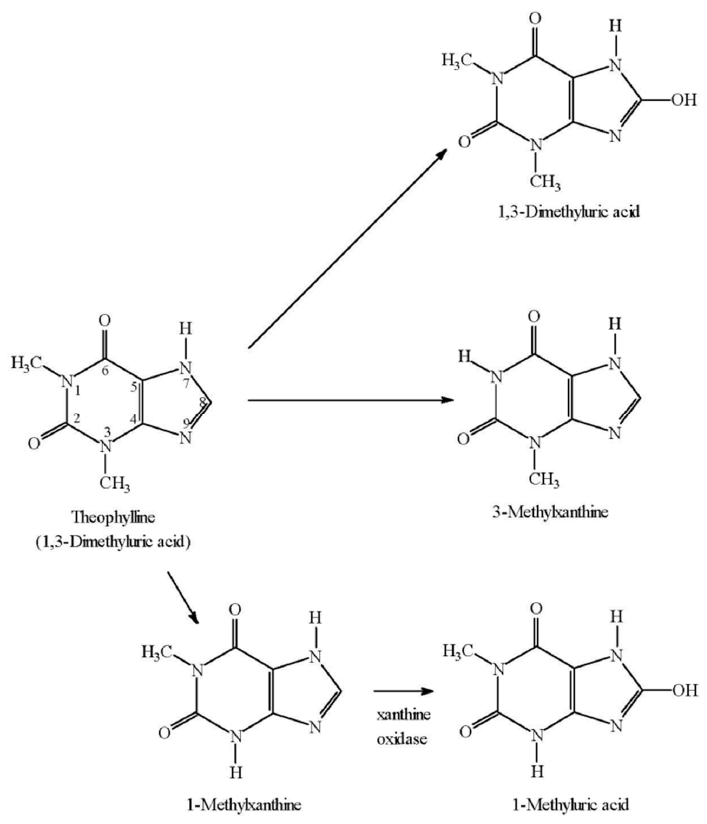
Figure 1. Summary of theophylline metabolism from urinary excretion data.